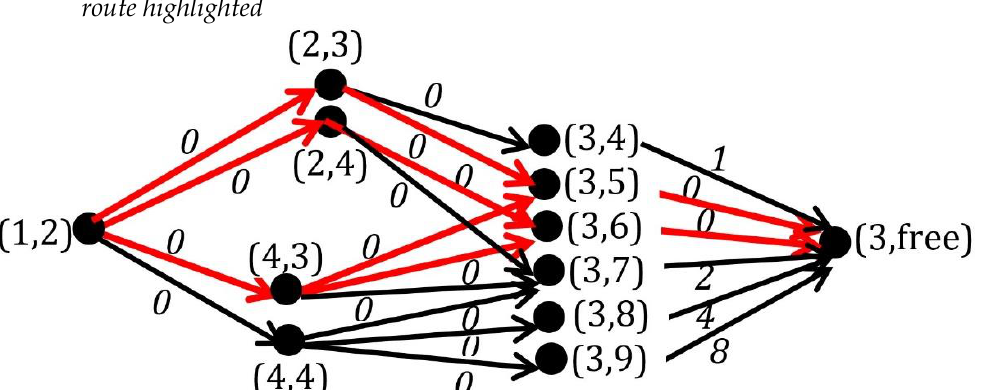
Figure 5. Weighted ESTEN graph for schedule penalty objective, with minimum schedule penalty space-time routes